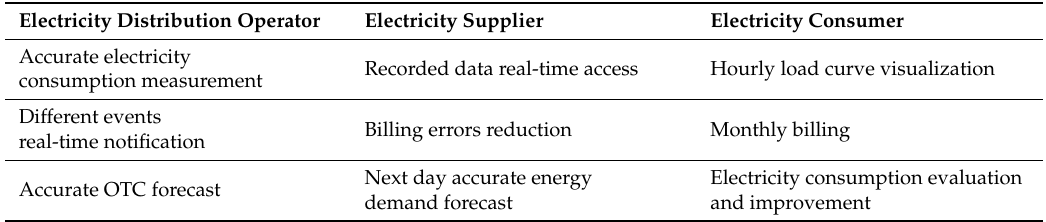
Table 1. Smart metering adoption